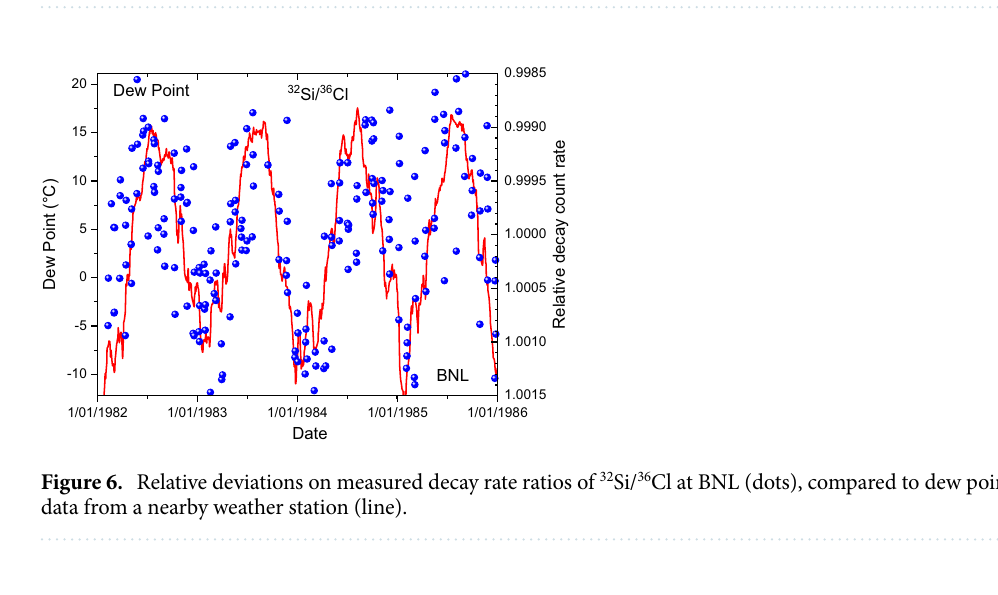
Figure 5. Relative deviations on measured decay rates of 32 Si at BNL (dots), compared to dew point data from a nearby weather station (line).